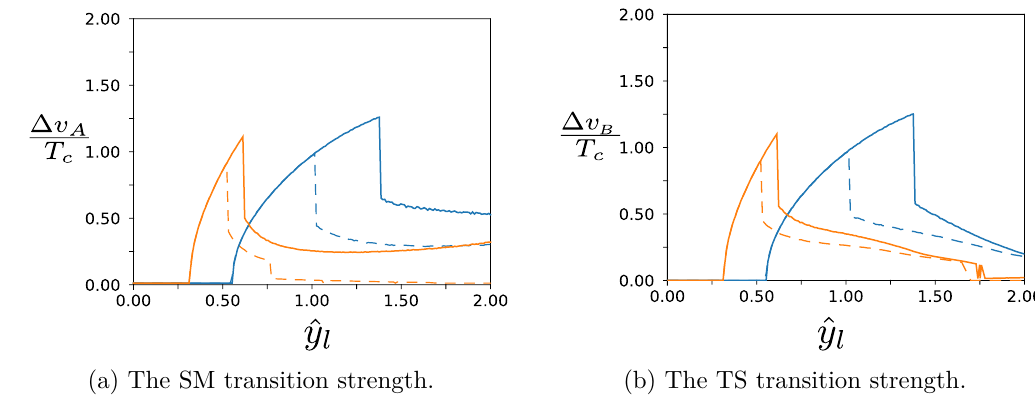
Figure 3. The phase transition strength ∆ v I ( T c ) /T c as a function of twin lepton Yukawa coupling ˆ y l for λ = 1 and ρ = 0 . Blue (orange) lines correspond to the case with the Yukawa couplings of one (all three) twin leptons equal to ˆ y l . Dashed and solid lines correspond to f 0 = 3 v A and f 0 = 4 v A ,